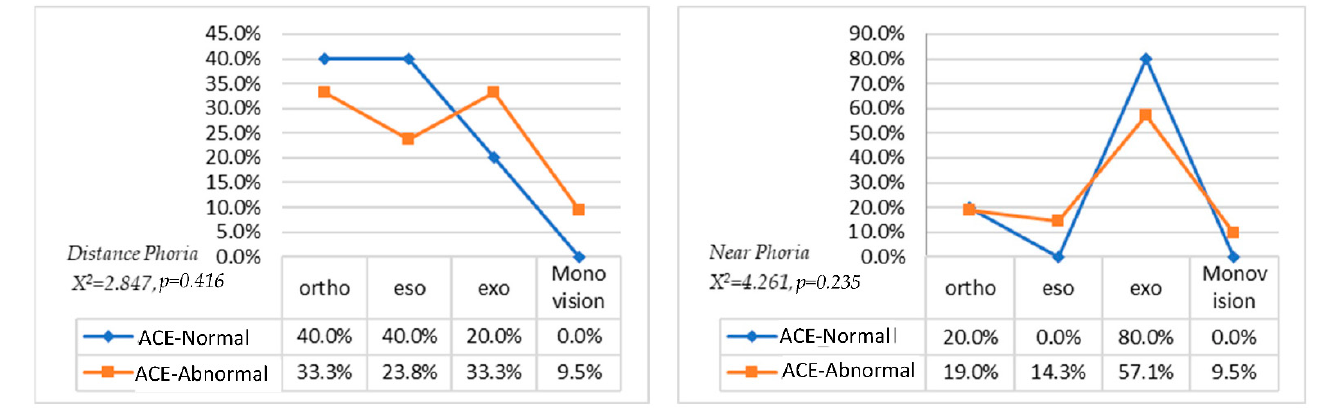
Figure 3. Distance phoria and near phoria between ACE-normal and -abnormal subjects.